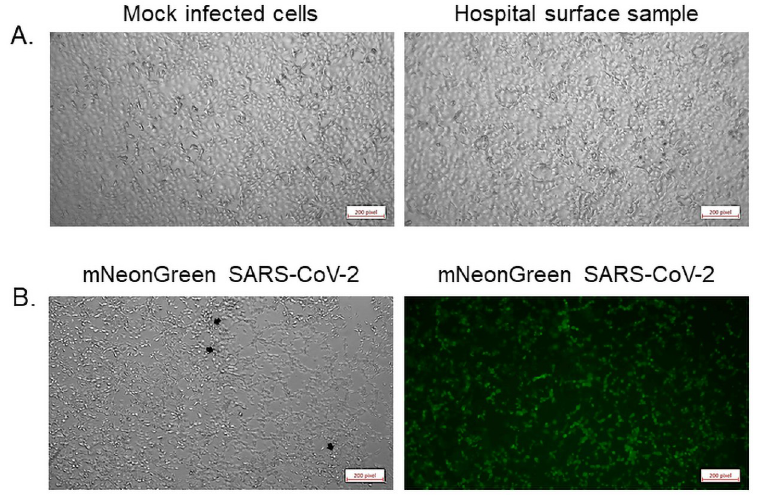
Fig 3. Micrographs of Vero E6 cells five days after inoculation. Cells were either mock-infected (upper left), inoculated with swab samples (representative of all five tested samples, upper right), or infected with one PFU of mNeonGreen SARS-CoV-2 (phase contrast, lower left; mNeonGreen lower right).